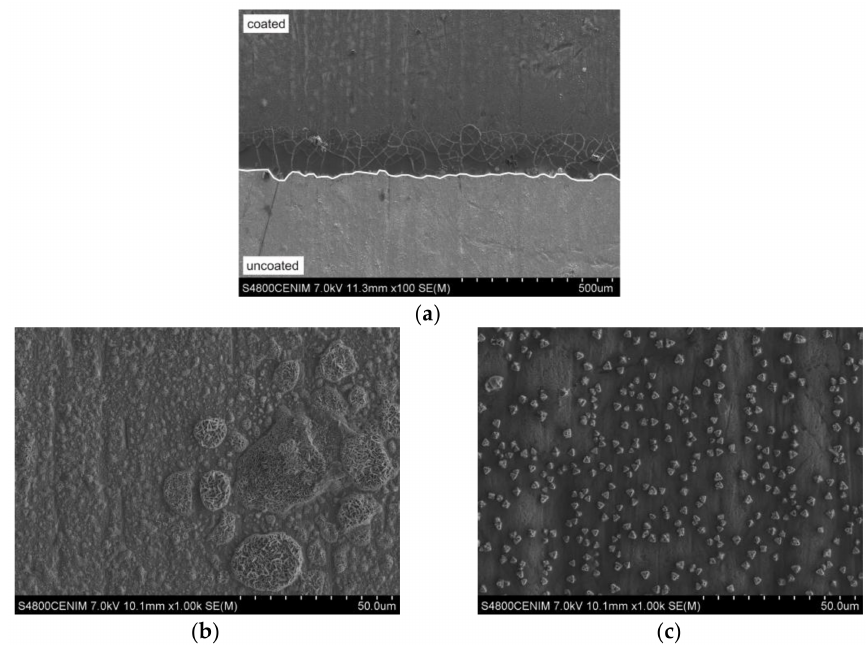
Figure 9. ( a ) FESEM image of a lead substrate in the coated/uncoated interface (La(Ac) 3 doped coating) after the weathering test under organic acids atmosphere; ( b ) Detail of the uncoated area; ( c ) Detail of the coated area.